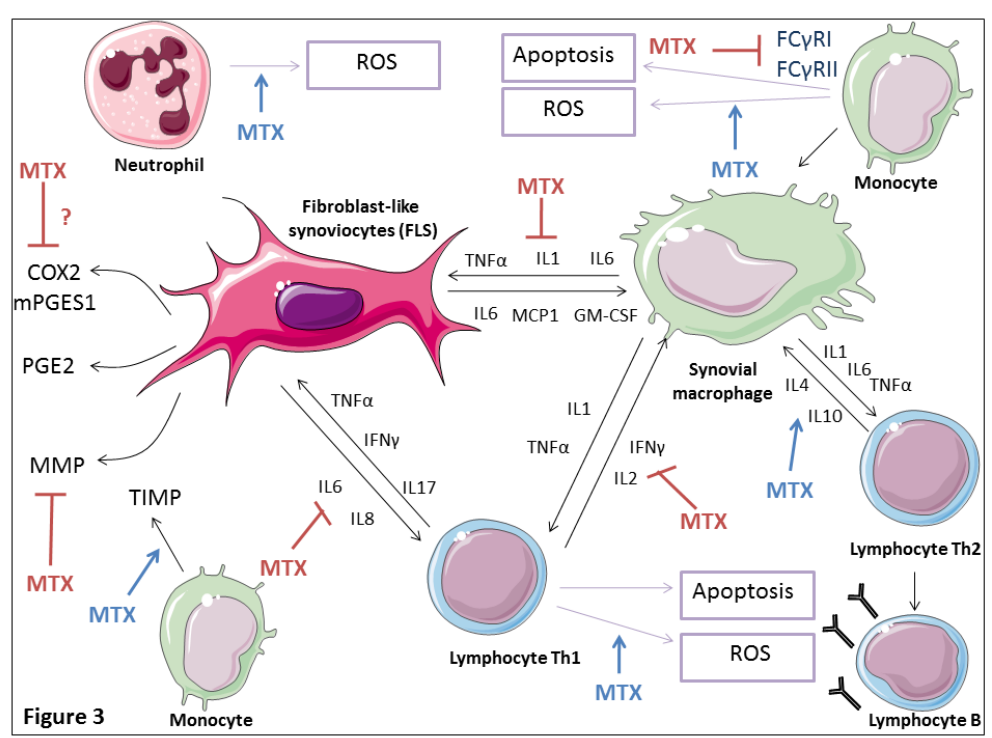
Figure 3. Immune regulatory action of low dose MTX in the RA synovial tissue. MTX treatment reduces proinflammatory monocytic / macrophagic cytokine (IL1 β , IL6, and TNF- α ) production, increases Th2 anti-inflammatory cytokine (IL4 and L10) gene expression, and decreases Th1 proinflammatory cytokine (IL2 and IFN γ ) gene expression. MTX downregulates IgG Fc receptors Fc γ RI and IIa expression levels on monocytes decreasing their activation. MTX seems to disrupt synovial fibroblasts and T